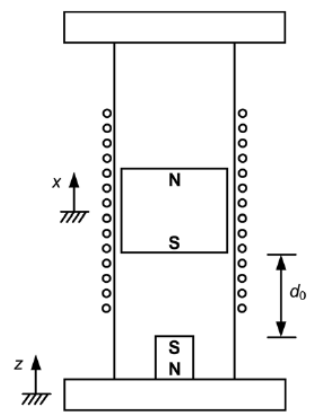
Figure 9: Schematic drawing of the magnetic inductive harvester prototype [5].